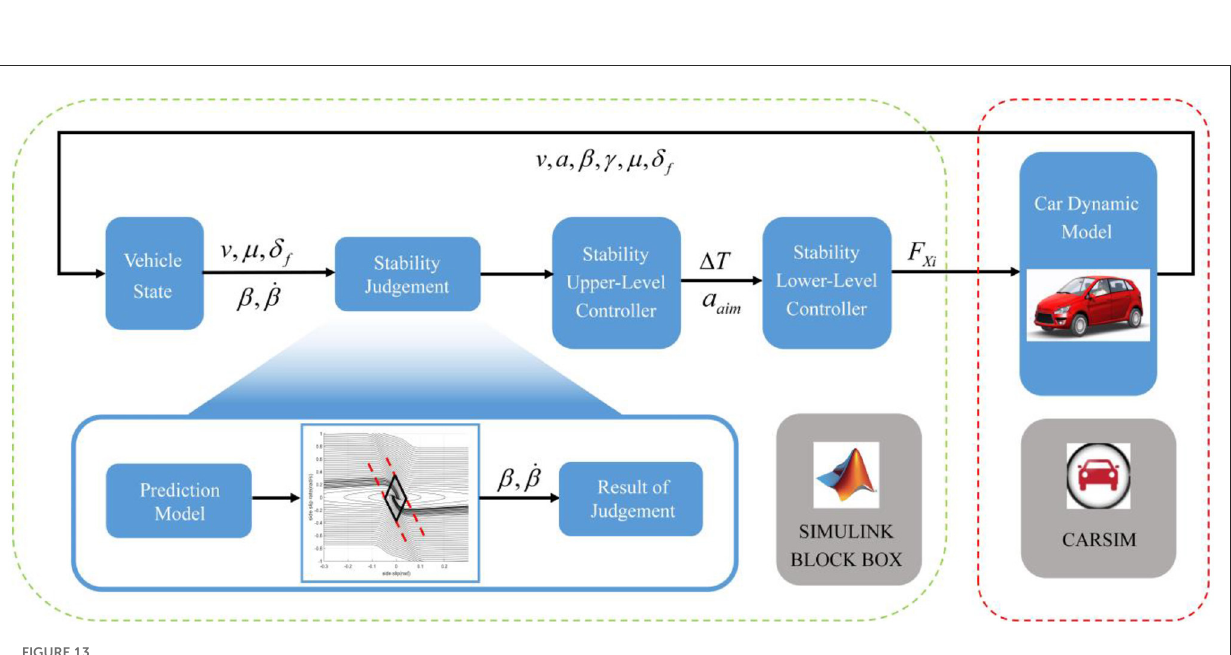
FIGURE13 Simulation test